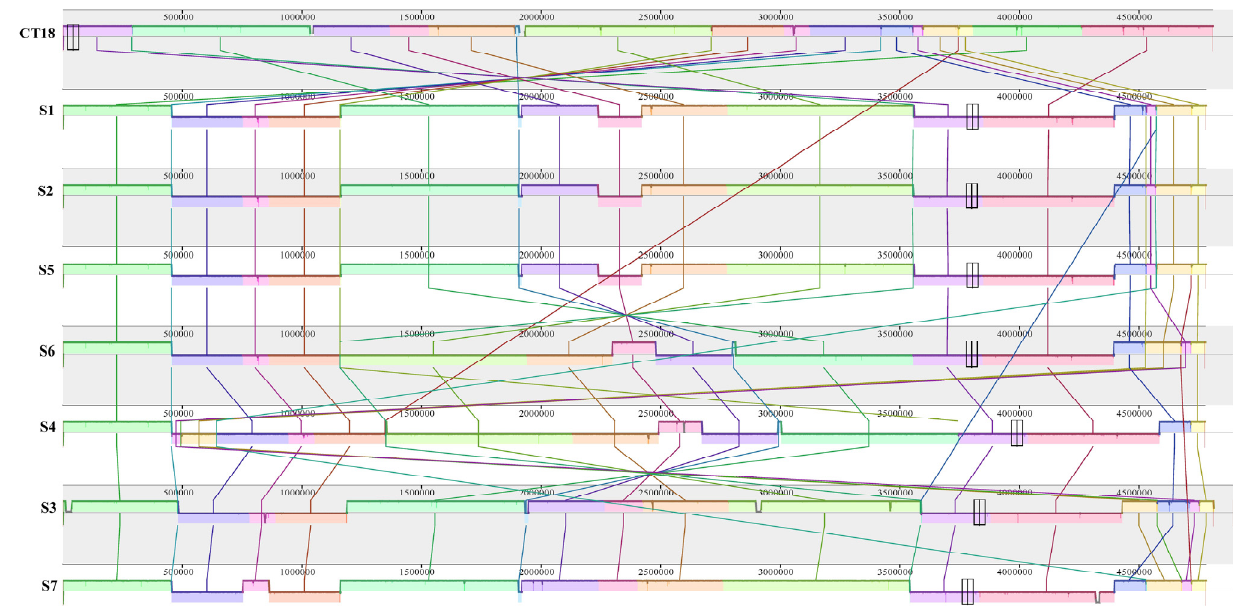
Figure 1. Mauve alignment of S1 to S7 genomes with the Salmonella Typhi reference CT18. Each coloured block (called locally collinear blocks) represents a region of homologous sequence that aligns to part of another genome and is free from internal rearrangement. Color lines indicate which blocks in each genome are homologous.